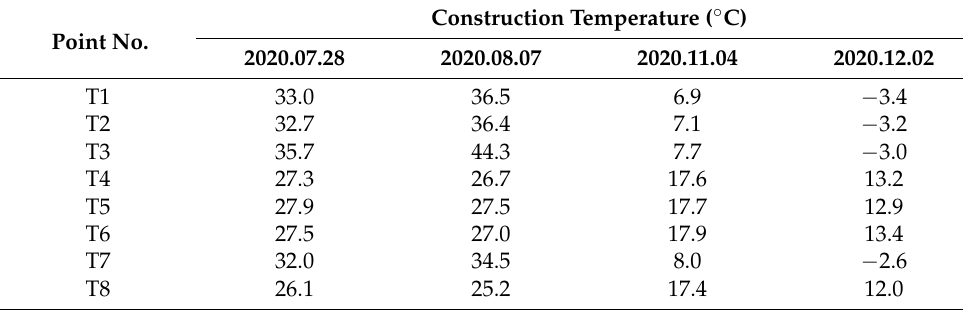
Table 2. Construction thermal overview. Point